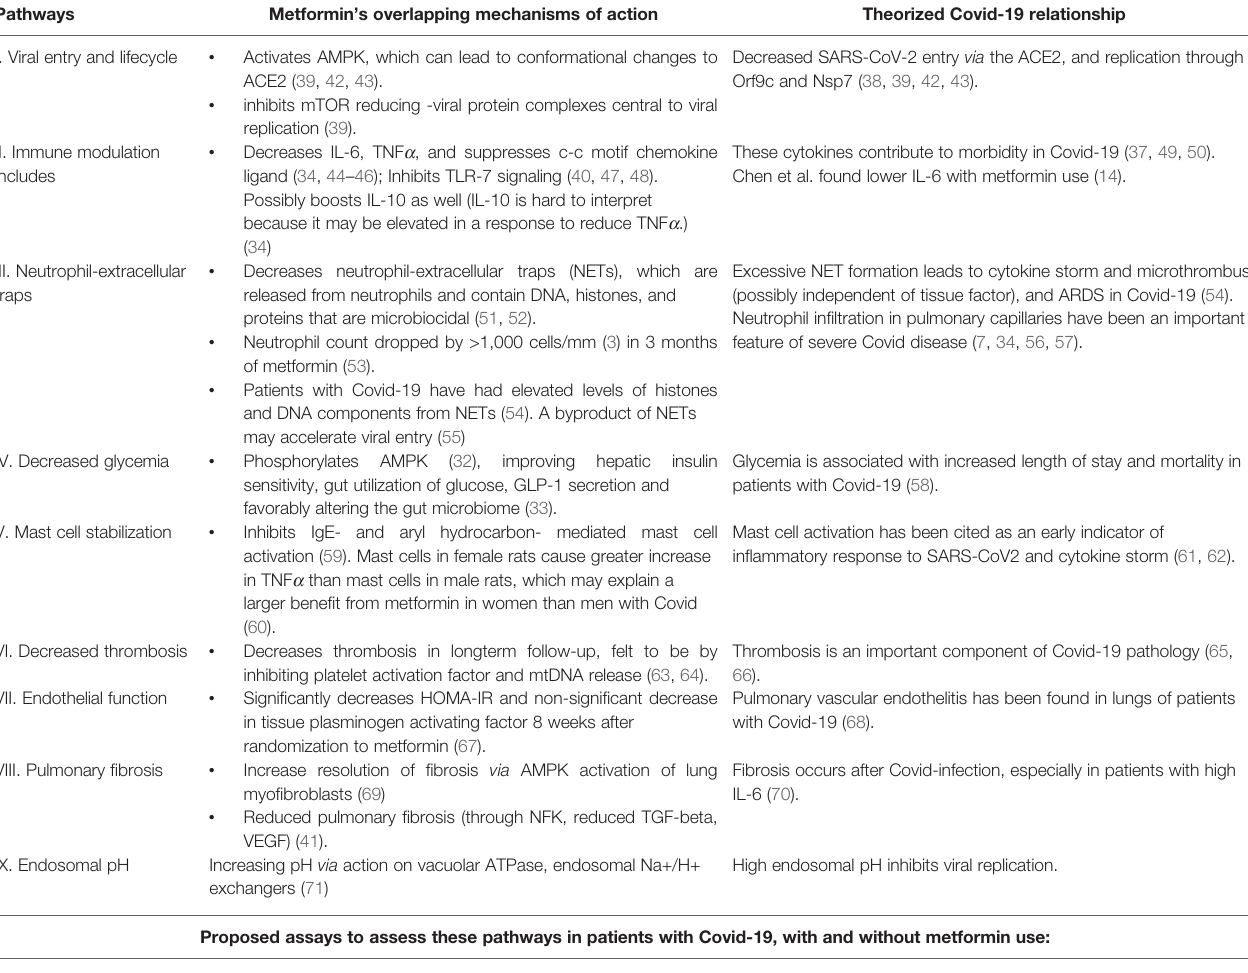
TABLE 2 | Overview of mechanisms of action of metformin and their relationship to SARS-CoV-2 infection.